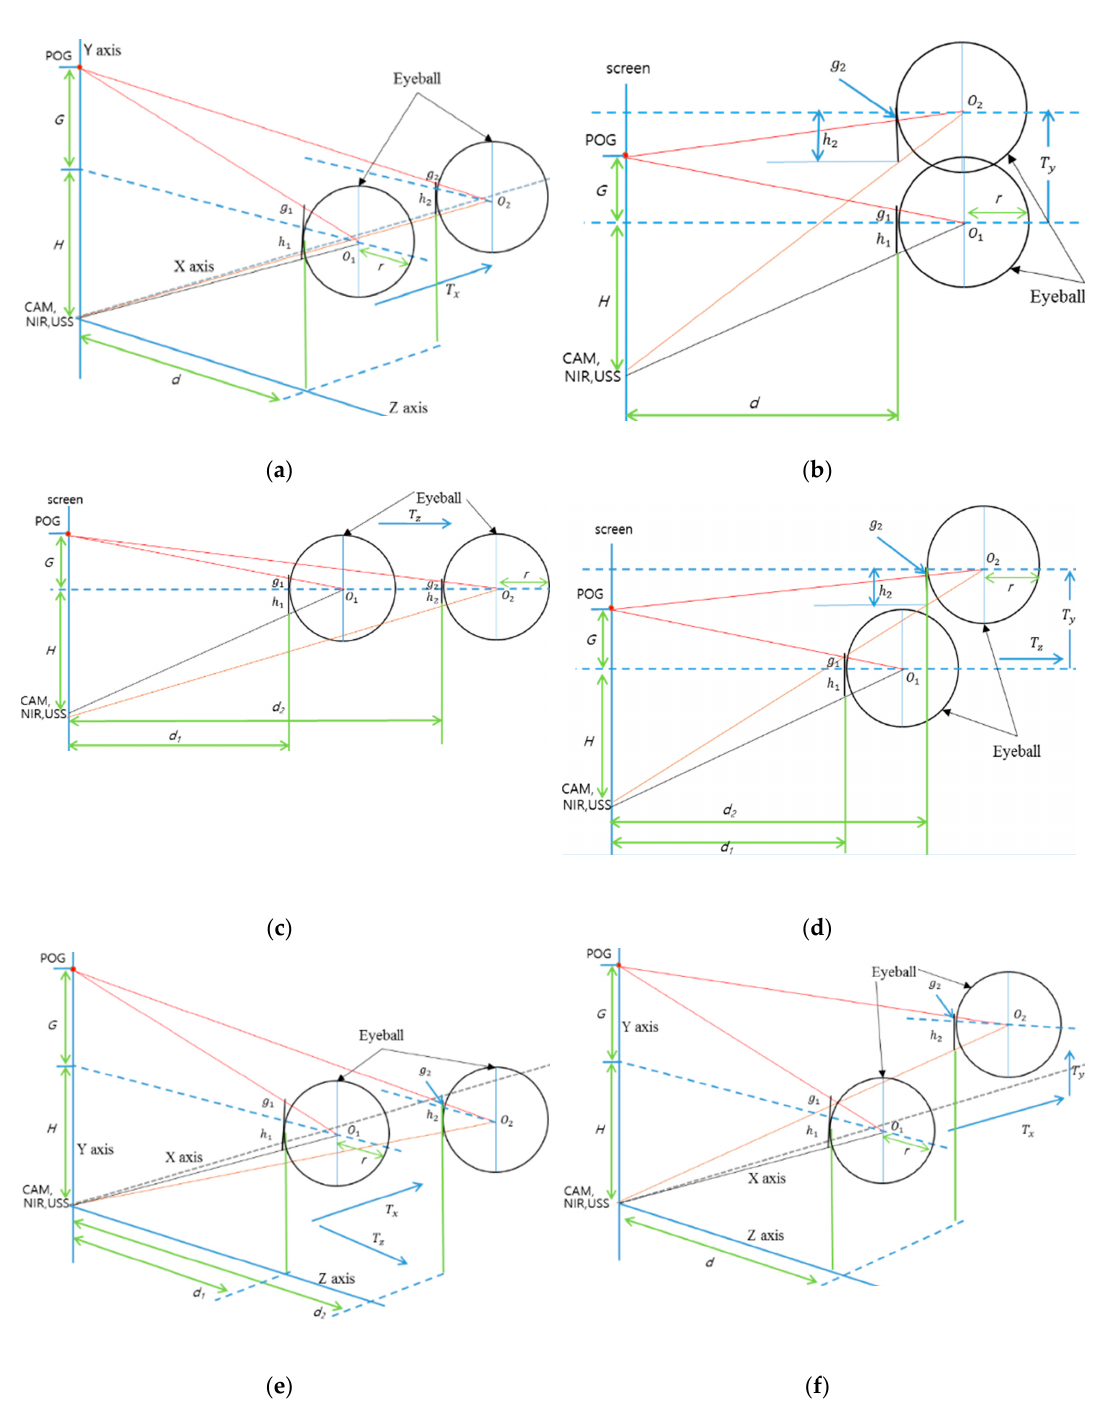
Figure 5. Conceptual diagrams of the changes of pupil-corneal SR vector according to head movements: ( a ) T_X movement, ( b ) T_Y movement (side view), ( c ) T_Z movement (side view), ( d ) R_X movement (compound of T_Y and T_Z, side view), ( e ) R_Y movement (compound of T_X and T_Z), and ( f ) R_Z movement (compound of T_X and T_Y).